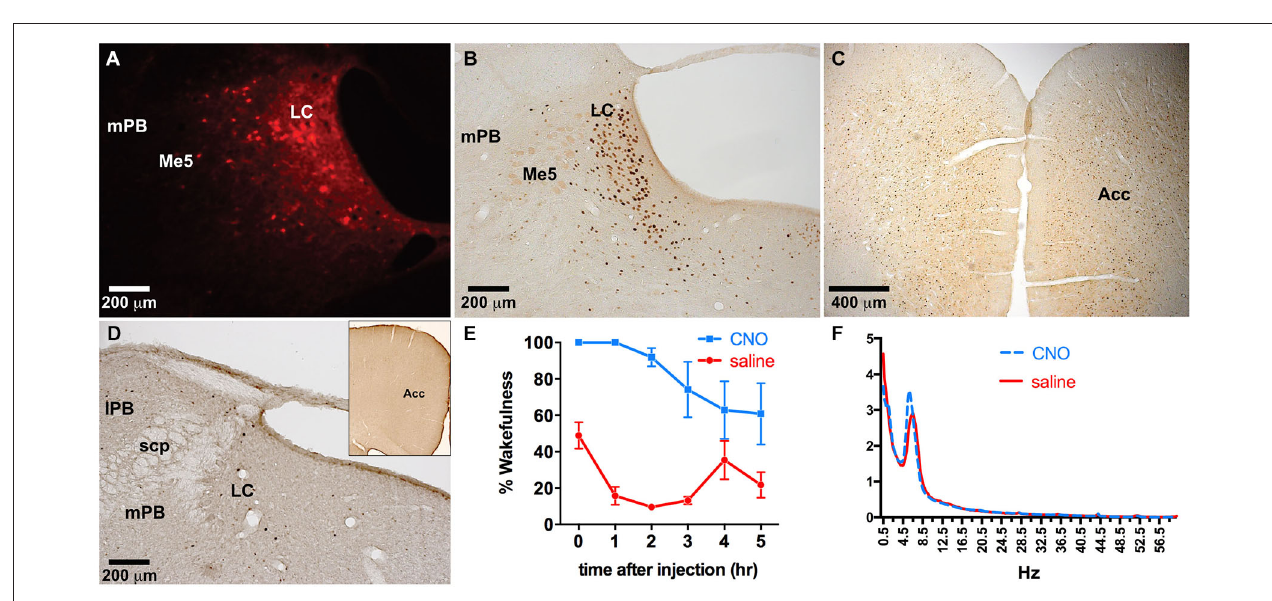
wakefulness for most of the 6 h period following injection (blue line) compared to the normal amount of wakefulness observed following saline injection (red line). (F) Power spectral analysis revealed normal wake EEG signatures following CNO injection compared to saline (blue and red lines,